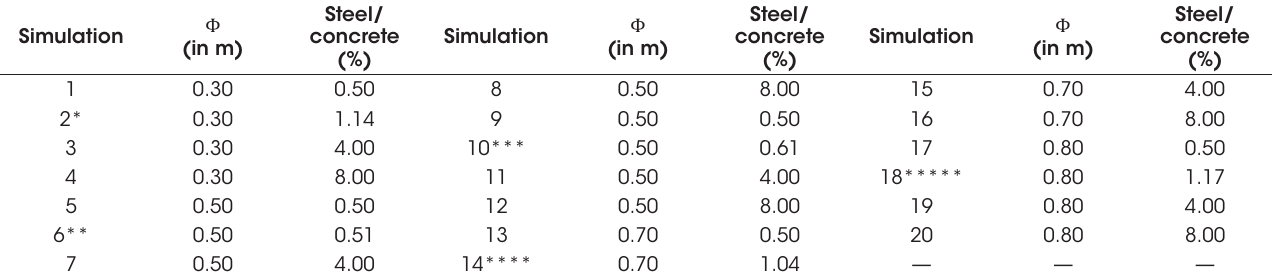
Table 3 Summary of the numerical simulations performed for comparison with field results